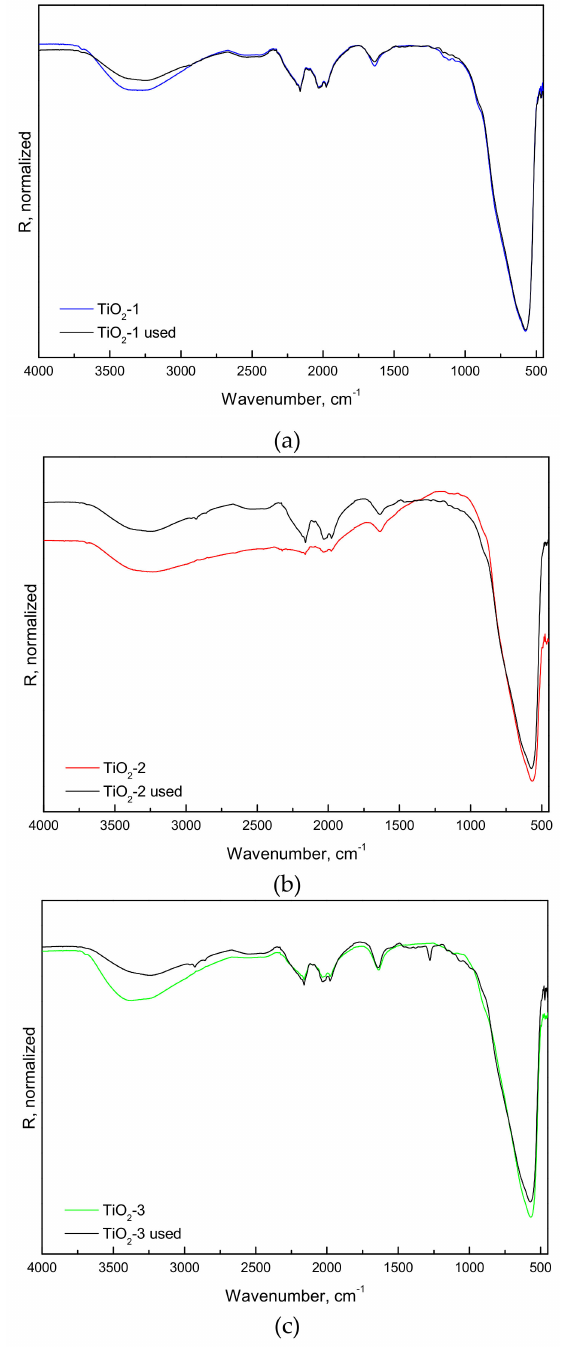
Figure 4. FTIR-ATR spectra of ( a ) TiO 2 -1, ( b ) TiO 2 -2 and ( c ) TiO 2 -3 samples before and after use in bisphenol A BPA degradation